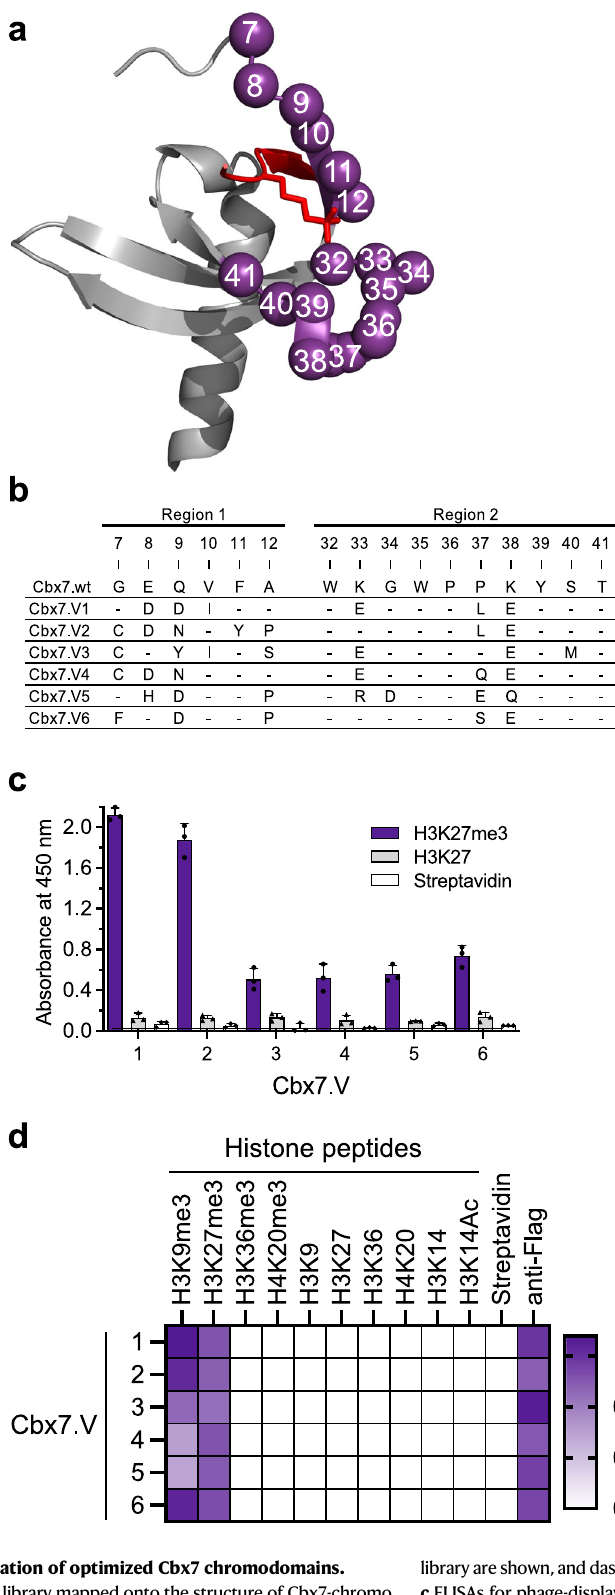
libraryareshown,anddashesindicateresiduesthatmatchedthewild-typesequence. c ELISAs for phage-displayed Cbx7.Vs binding to immobilized H3K27me3 peptide, H3K27 peptide or streptavidin. Data represent the mean and standard deviation of triplicatemeasurements. d PhageELISAsforassessmentofspeci fi cityofFlag-tagged Cbx7.Vsbindingtoimmobilizedhistonepeptides,streptavidin(negativecontrol),or anti-Flag antibody (positive control). The heatmap shows the mean of absorbance values at 450nm from three independent experiments in a purple